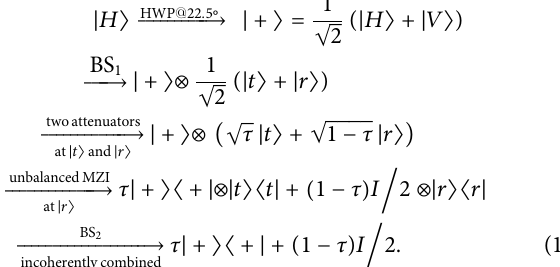
is detected with projective RE